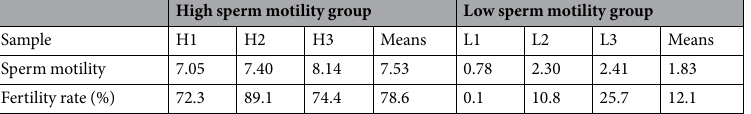
Table 2. Sperm motility and fertility rate of six cocks involved in